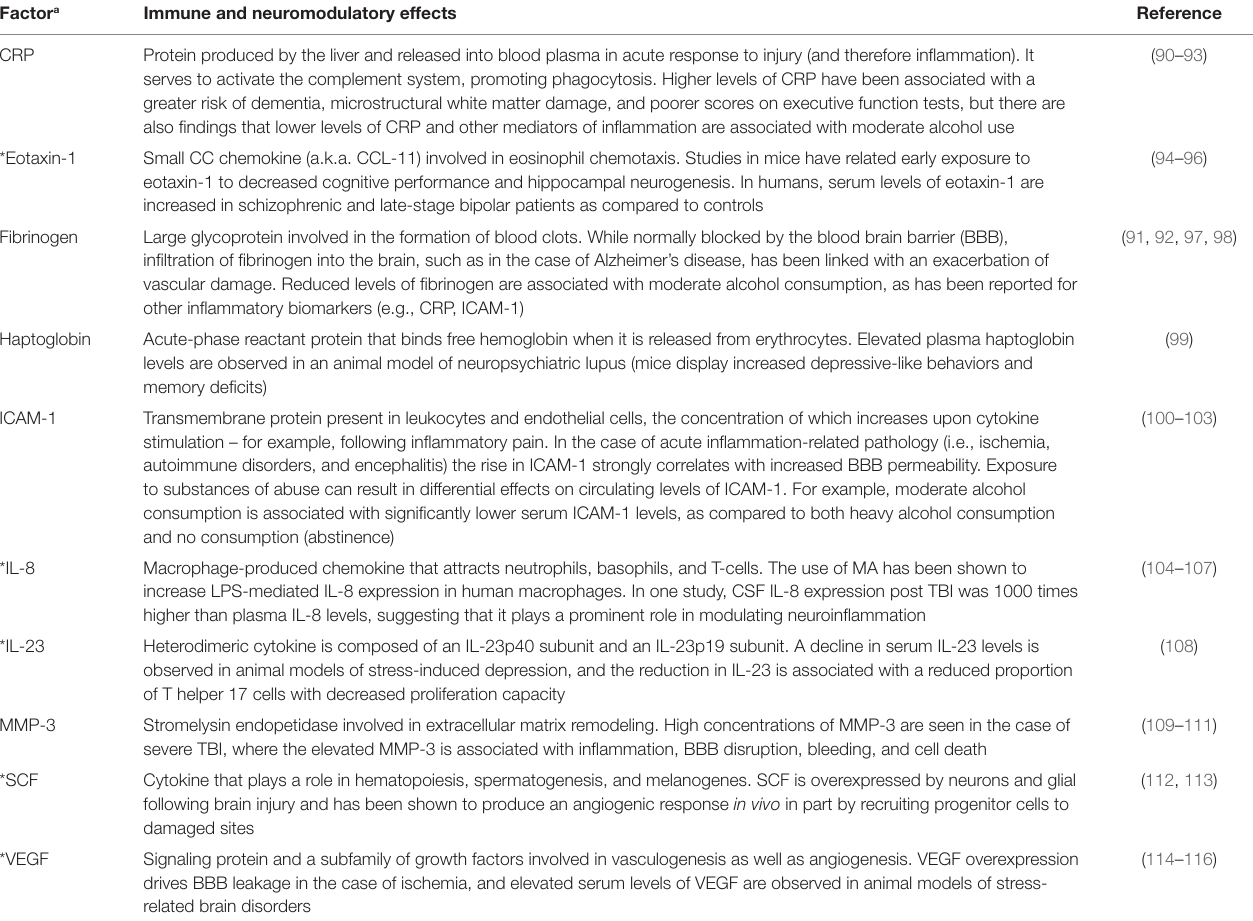
TaBle 4 | immune and neuromodulatory effects of inflammatory factors associated with neuropsychiatric symptomatology. Factor a immune and neuromodulatory